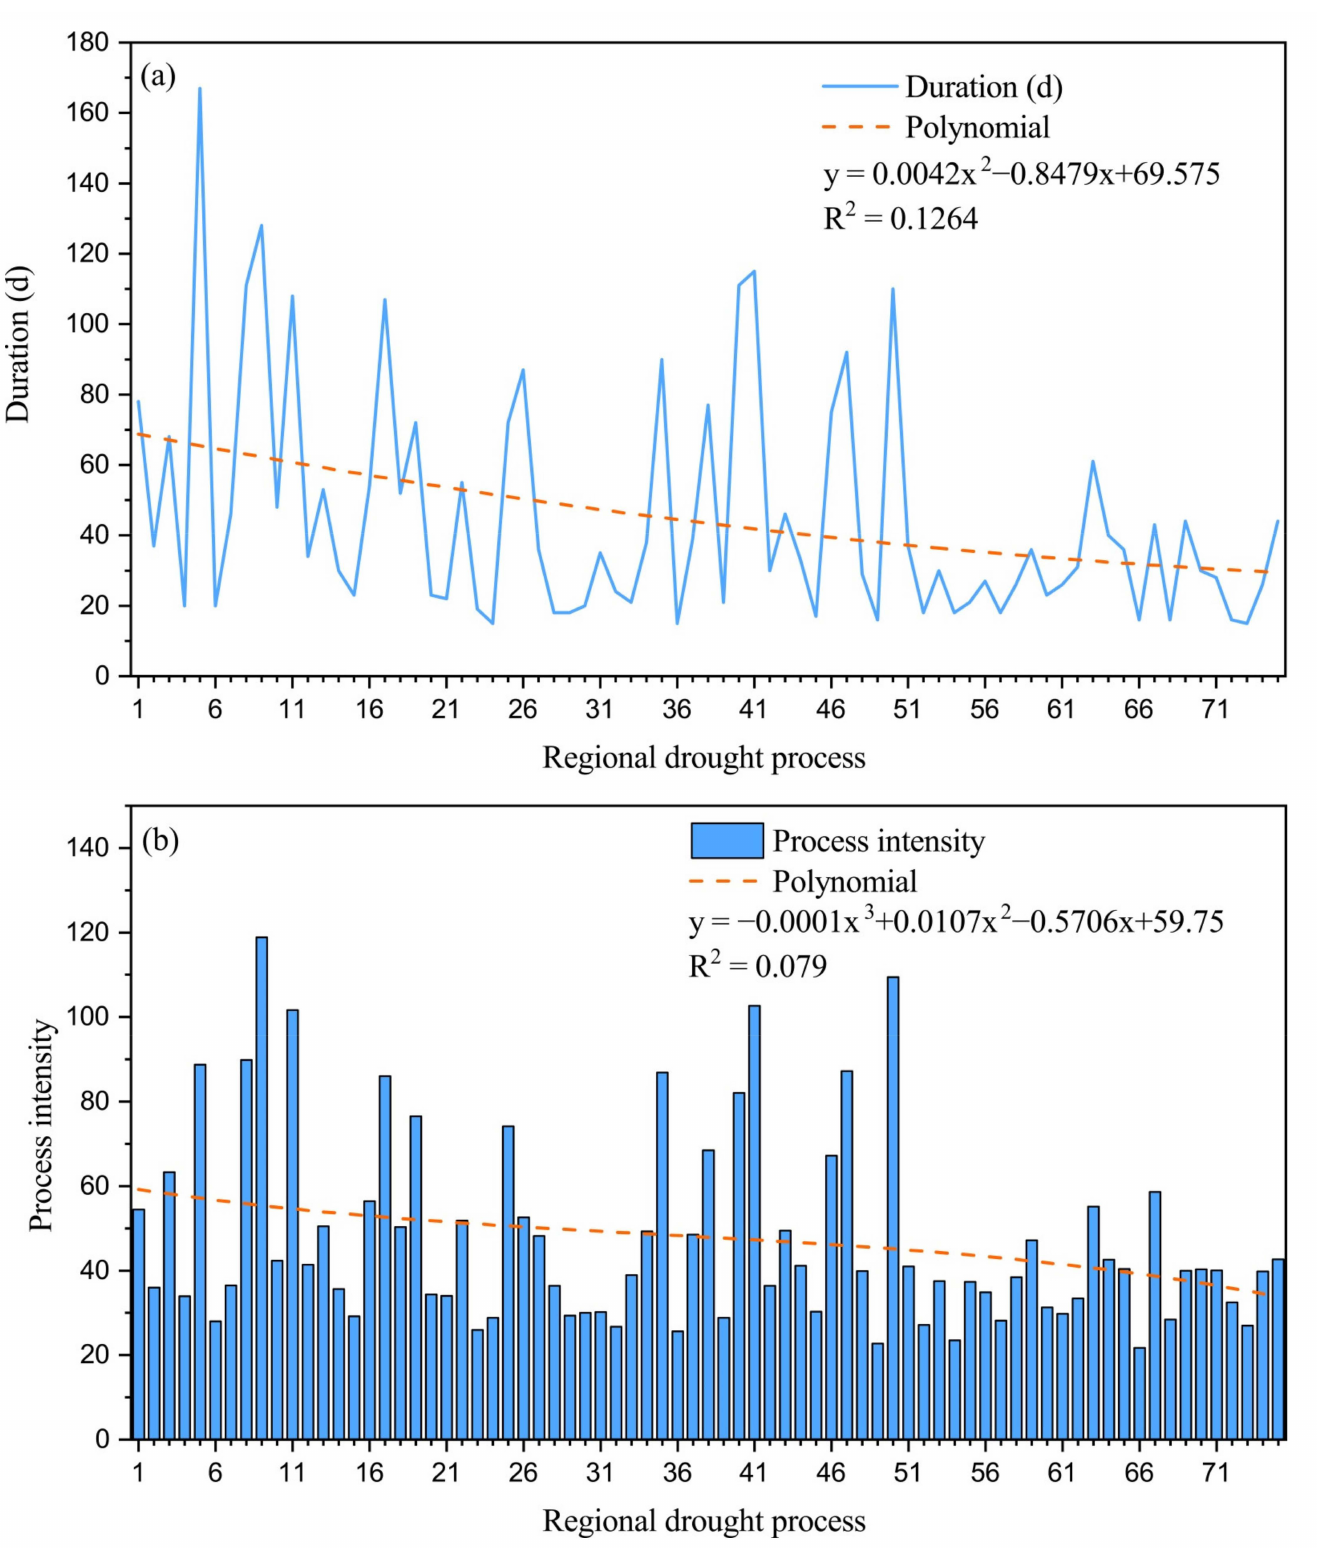
Figure 8. Variation of duration ( a ), comprehensive intensity ( b ) of regional drought processes in North China from 1960 to 2019. The annual drought-affected areas of each province were obtained, and the annual drought process intensity of each station in North China in the same period (1971–2019) was extracted to obtain the average annual drought process intensity and the evolution